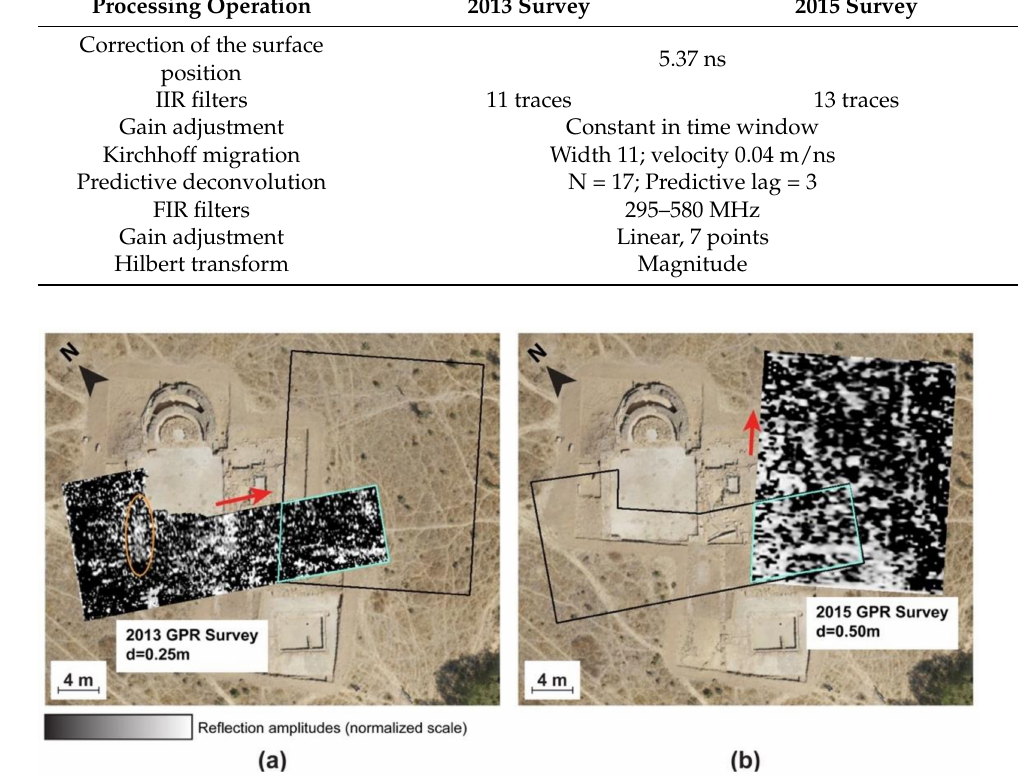
Figure 3. ( a ) Location and results of the 2013 survey (B-scan spacing of 0.25 m). ( b ) Location and results of the 2015 survey (B-scan spacing of 0.50 m). The base map is an orthophoto of Horta da Torre that was taken in 2016. The excavations took place after the GPR surveys. Arrows indicate the direction of the B-scans, and the orange line shows the location of the discovered wall in Figure 2a. The blue line delimits the common part of the two GPR surveys. All the results show reflection alignments, suggesting the existence of wall-type structures. The difference in B-scan spacing is visible in the two datasets; it mainly affects spatial